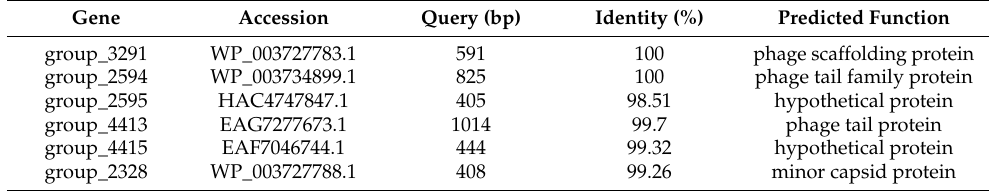
Table 3. Scoary identified genes specific to cold tolerance and their prediction function (BLASTX).